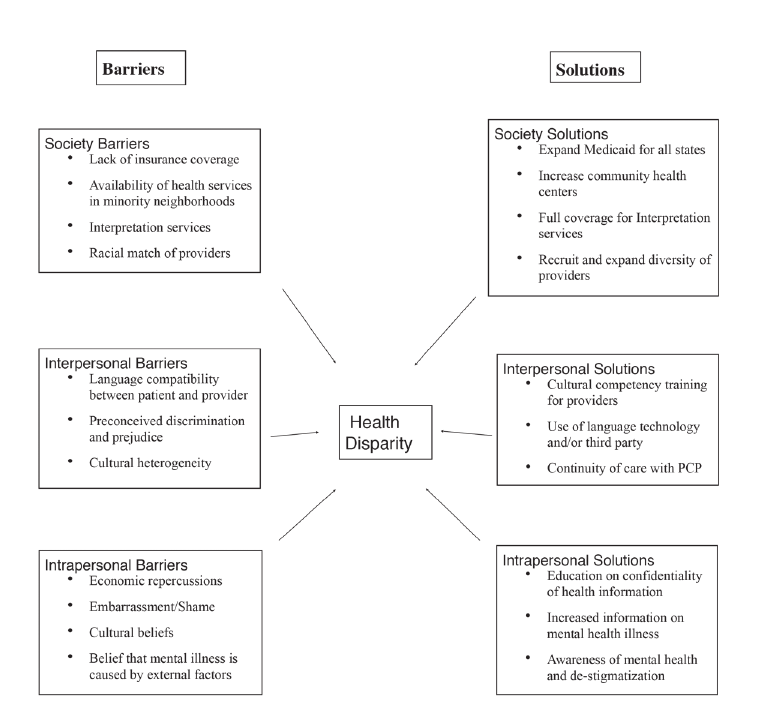
Figure 1. Barriers and solutions to health